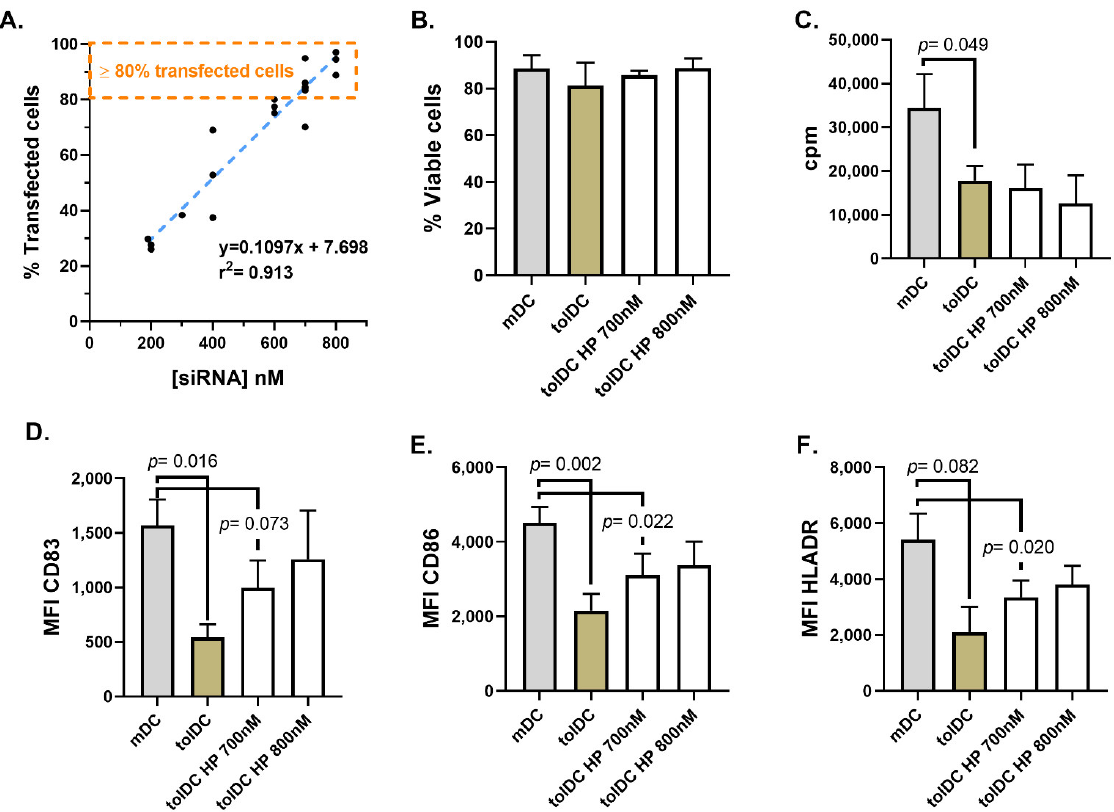
Figure 1. HiPerfect (HP) transfection of monocytes after maturation stimulus using 700 nM and 800 nM of siRNA. Linear regression between the percentage of transfected cells and the concentration of red-labeled non-targeting siRNA (siGLO, negative and red-labeled siRNA control) used ( A ). Characterization of control untreated mDC and VitD3-tolDC, and VitD3-tolDC obtained following HP transfection using 700 nM and 800 nM of siRNA by analyzing their viability ( B ), functionality (ability to induce allogeneic PBMC proliferation using a ratio of DC/PBMC of 1/20) ( C ), and phenotype (mean fluorescence intensity, MFI, of CD83 ( D ), CD86 ( E ) and HLA-DR ( F ) molecules). Data shown as mean + SEM. For all group n = 4, except for tolDC HP 800 nM in which n = 3.